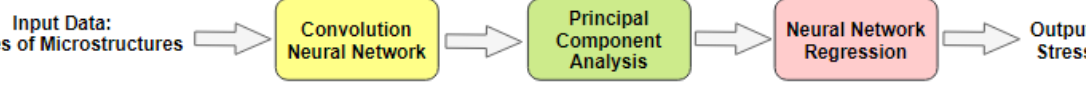
Figure 5. Methodology of microstructure–stress